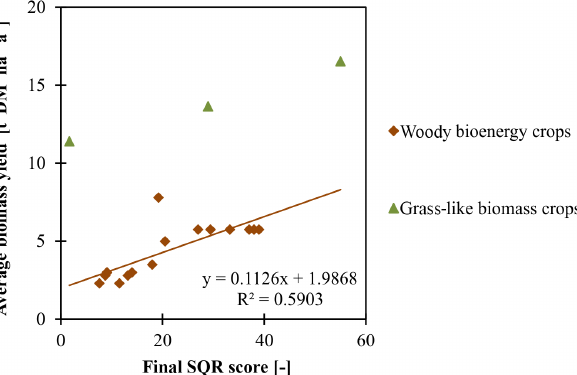
Figure 4. Overview of SQR basic and final scores for investigated marginal case study sites. Figure 5. Correlation between final SQR scores and estimated av- erage biomass yields for woody bioenergy crops with linear regres- sion line ( n = 16, r = 0 . 84 ∗∗ , p <0.01) and grass-like bioenergy crops ( n = 4, no correlation coefficient